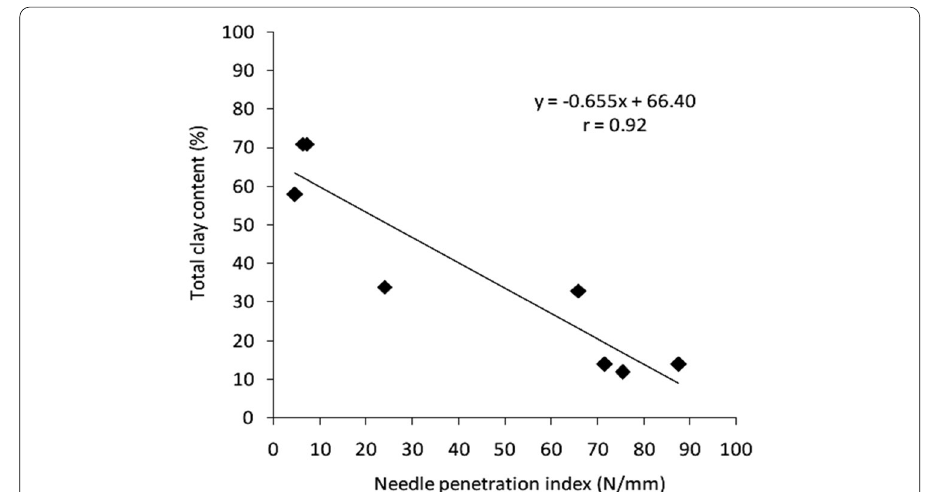
Fig. 8 Correlation between the NPI and the total clay content excluding the data point of location E 209–104 m